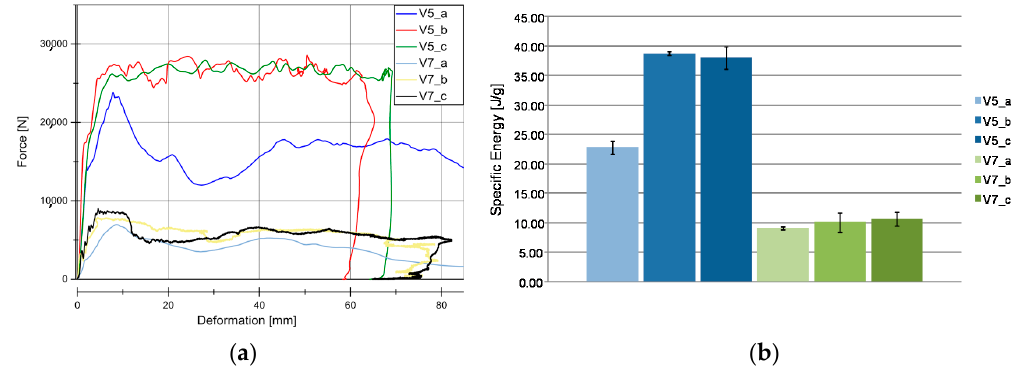
Figure 19. Results for V5 and V7 materials. ( a ) Load-Deformation curve for V5 and V7 materials under different velocity rates under crash tests conditions; ( b ) SEA evaluation in V5 and V7 (Twill/PLA and Twill/HD-PE matrix influence evaluation).